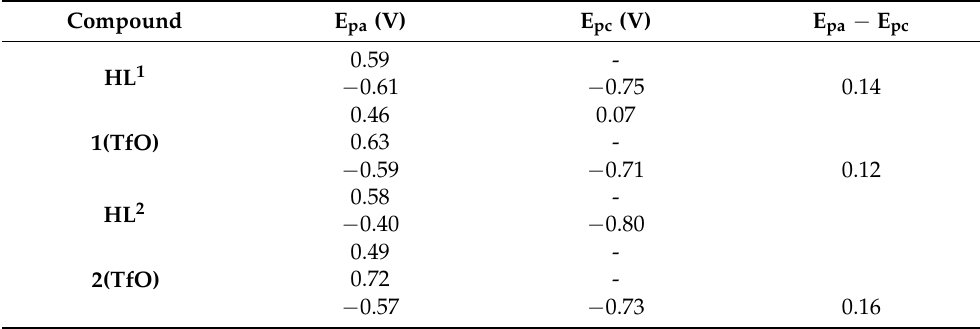
Figure 4. The X-ray structure of the cation in [Ru 2 ( p -Cm) 2 ( μ -L 2 ) 2 ][O 3 SCF 3 ] 2 ( A ) and the molecular association based on H-bonding in the crystal ( B ). Table 3. Electrochemical data for complexes and the corresponding ligand in methanol at a scan rate of 0.2